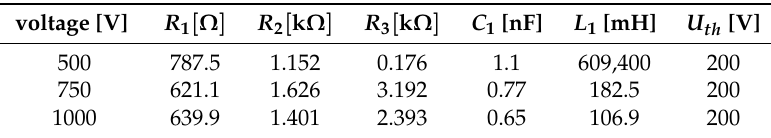
Table 1. Optimal values of electronic components for the single positive monopolar pulse model, for each applied voltage, at assumption U th = 200 V (Figure 3a). Used as initial values for LSE regression (Figure